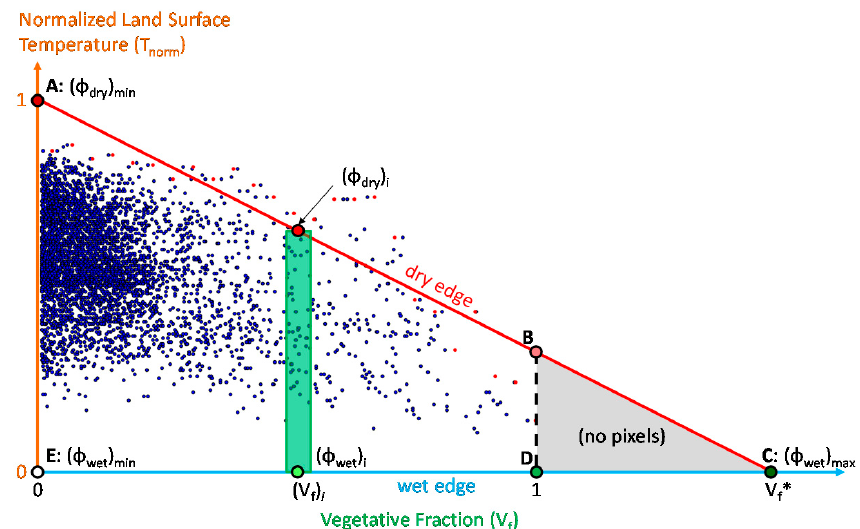
Figure 5. A conceptual temperature-vegetation triangle for the Triangle Algorithm with Variable Edges (TAVE). The vertical axis is the normalized land surface temperature ( T norm ), with 0 and 1 indicating the lowest and highest land surface temperatures over the domain, respectively. The horizontal axis is vegetative fraction ( V f ), with 0 and 1 indicating the lowest and highest NDVI values over the domain, respectively. The green bar shows an example of a vegetation bin. Points A and E represent the surfaces with the least vegetation cover and contrasting evaporation capacities. Points B and D represent the highest observed vegetation abundance under maximum and minimum water stress, respectively. Point C indicates a hypothetical pixel that has a sufficiently-dense vegetation cover ( V f = V f * > 1) and is able to fully satisfy the maximum φ . Lines AC and EC represent the dry and wet edges, respectively. Blue dots indicate observed pixels over the domain and red dots indicate pixels with maximum T norm values in individual vegetation bins. The observed pixels are located in the trapezoid ABDE. The grey triangle BCD suggests a hypothetically fully vegetated surface that is not observed in the image due to limited spatial resolution or environmental constraints. Along the dry edge, φ varies linearly from 0 at point A and φ max = 1.26 at point C. Along the wet edge, φ increases from 0.5 φ max at V f = 0 to 1.0 φ max at V f = 1. For any specific vegetation bin ( V f ) i (shown as the green bar), φ value varies linearly between the upper bound on the wet edge ( φ wet ) i and the lower bound on the dry edge ( φ dry ) i